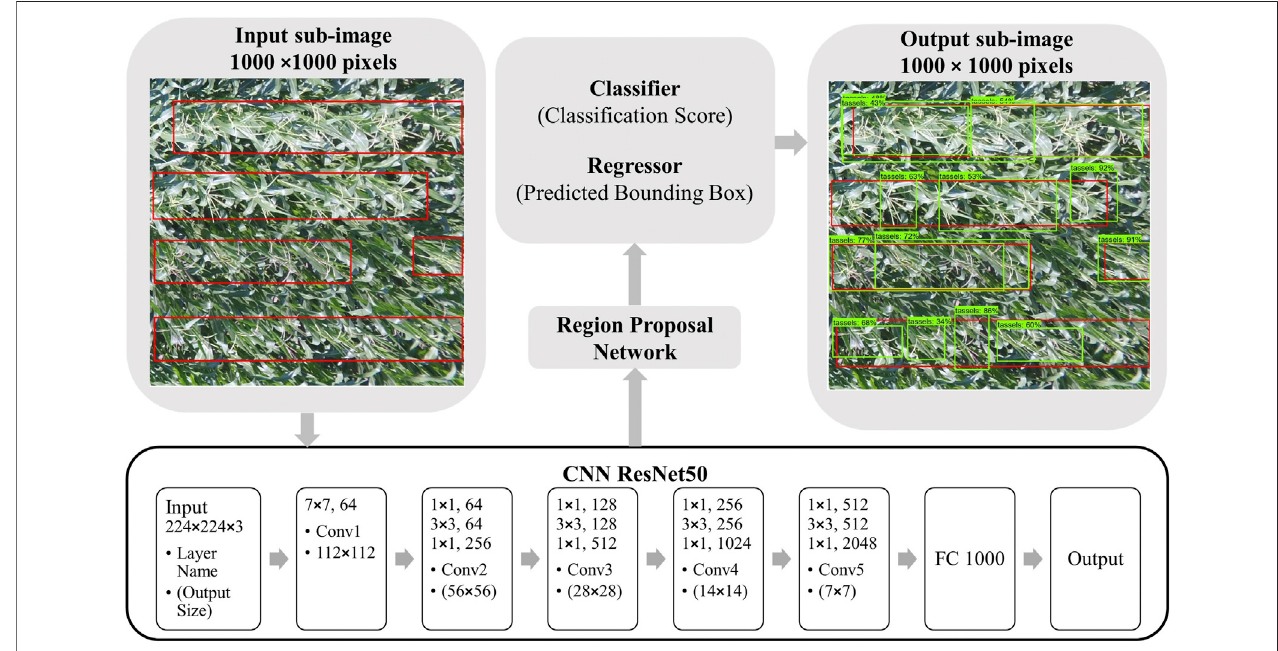
FIGURE 4 | [Best viewed in color] Faster R-CNN tassel detection model trained with ResNet50 with input and output image examples.